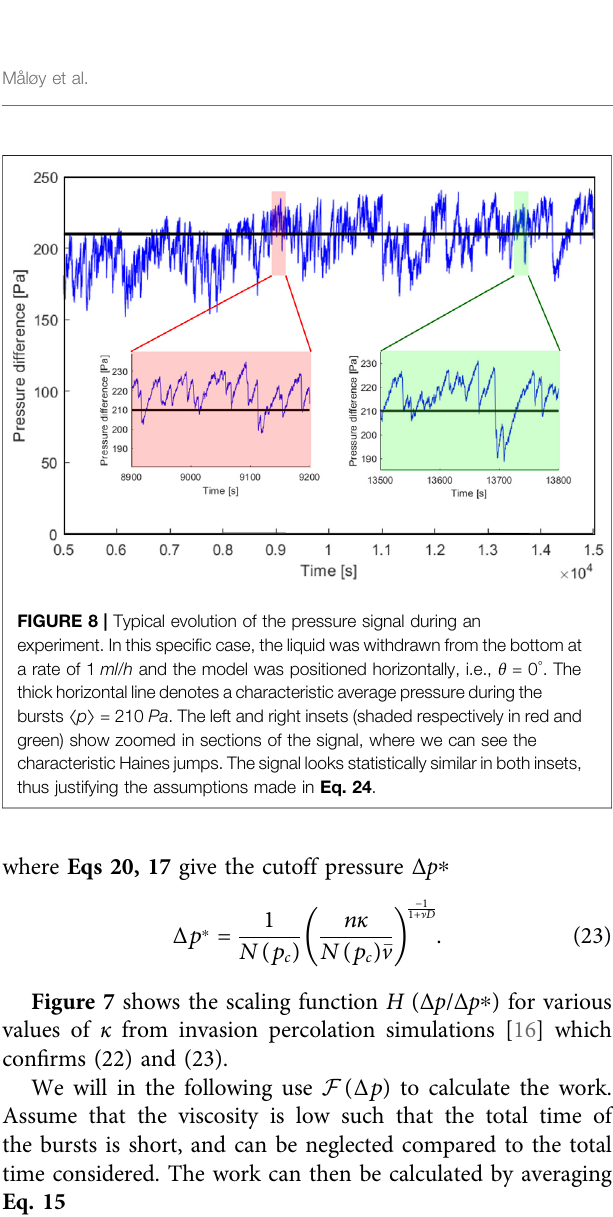
Frontiers in Physics |